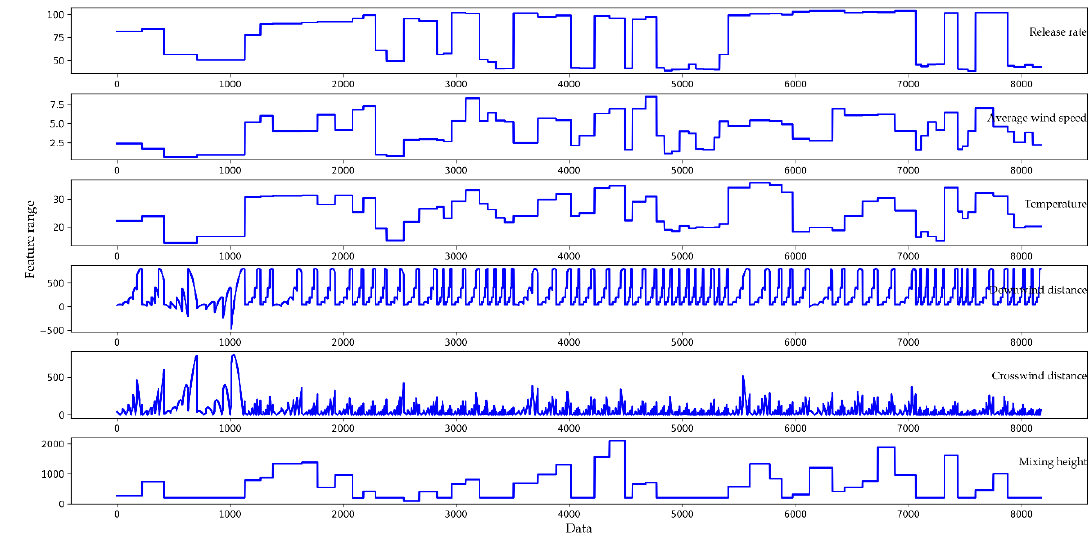
Figure 5. The feature parts of the original dataset: from top to bottom, the representative features are release rate, average wind speed, temperature, downwind distance, crosswind distance, and mixing height.